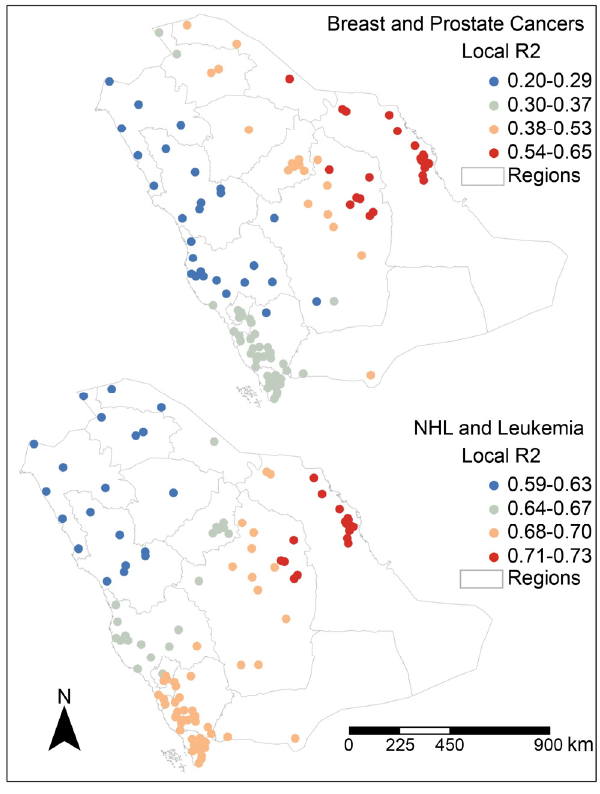
Figure 7. Spatial distribution of local coefficients of determination (r²) derived from GWR